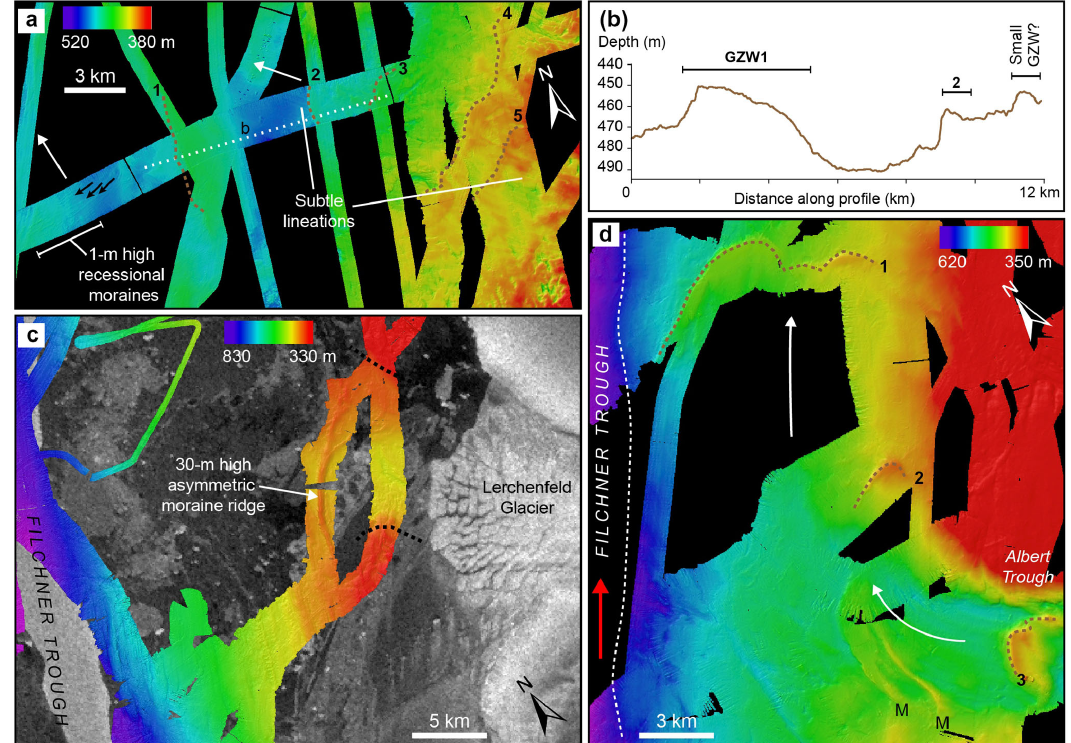
Figure 7. Detail of landform assemblages west of the Coats Land glacial troughs indicating connections to the main ice stream advance and retreat in Filchner Trough. (a) A series of five GZWs marked by numbered dashed lines and recessional moraines marked by arrows > 20km north of Caird Trough with cross profile in (b) ; profile across three of the GZWs west of Caird Trough. The location of the profile is marked by the white dotted line in (a) . (c) Landforms in Vashel Bay formed by extension of the Lerchenfeld and Schweitzer glaciers. The approximate trough margins, based on the bathymetry, are marked with black dotted lines. (d) Landforms west and north of Albert Trough showing lineations (labelled “M”) trending parallel to past ice flow in Filchner Trough (red arrow) and across-flow GZWs marked by numbered dashed